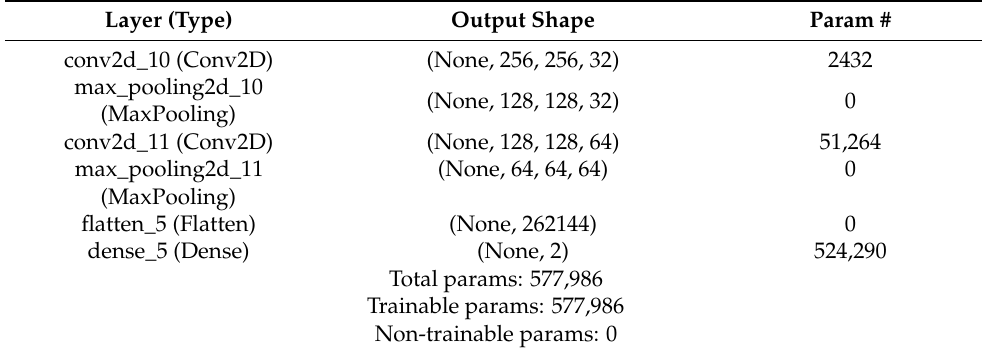
Table 1. Summary of Image Classifier